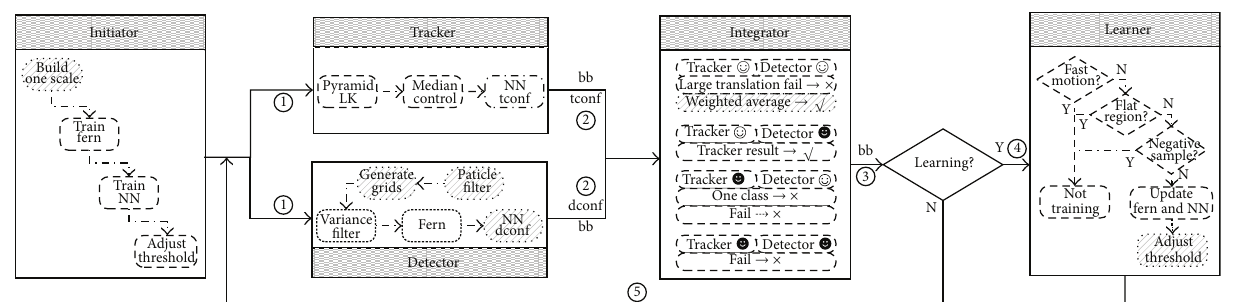
Figure 4: Flowchart of AA-TLD for target tracking. The marks white smile face and black smile face separately stand for success and failure symbols. The notations √ and × are learning flags, which mean learning or